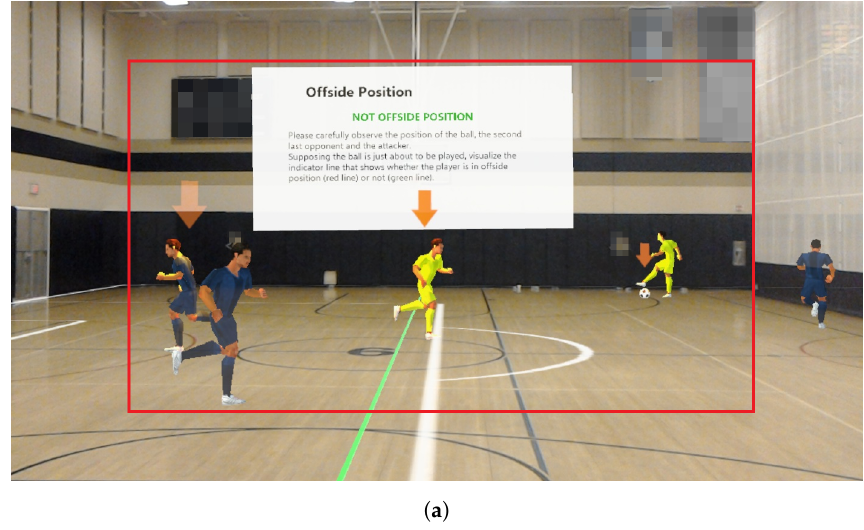
Figure 2. This is a picture that represents the perspective of the user in the Augmented Reality study condition. However the user is able to see just a small rectangular area around the text canvas. Red rectangle shows a rough view of the visible